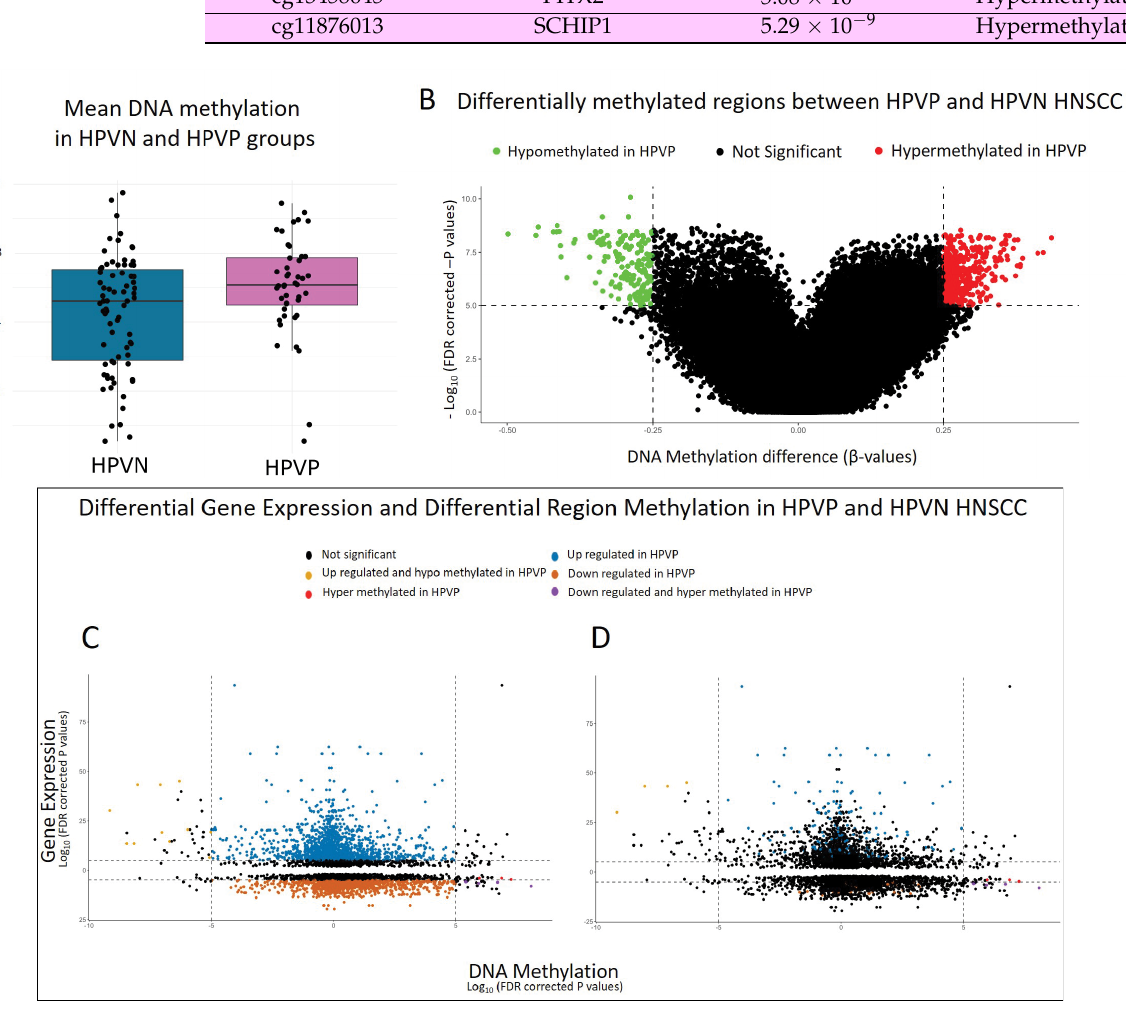
Figure 4. Differential methylation in HNSCC patients. Represented above is the methylation profile in HNSCC. ( A ) Mean methylation between HPVN and HPVP HNSCC patient samples; ( B ) volcano plot showing the hypomethylated genes in green and hypermethylated genes in red. HPVN samples are used as a baseline. We used β ≥ 0.25 and p ≤ 10 − 5 ; ( C , D ) show a Starburst plot that combined differential gene expression data with differential methylation data. HPVN is used as a baseline. We used β ≥ 0.25, FDR expression ≤ 10 − 5 , FDR DNAmethylation ≤ 10 − 5 |logFC| ≥ 1 in ( C ) and more stringent parameters β ≥ 0.25, FDR expression ≤ 10 − 5 , FDR DNAmethylation ≤ 10 − 5 |logFC| ≥ 3 in ( D